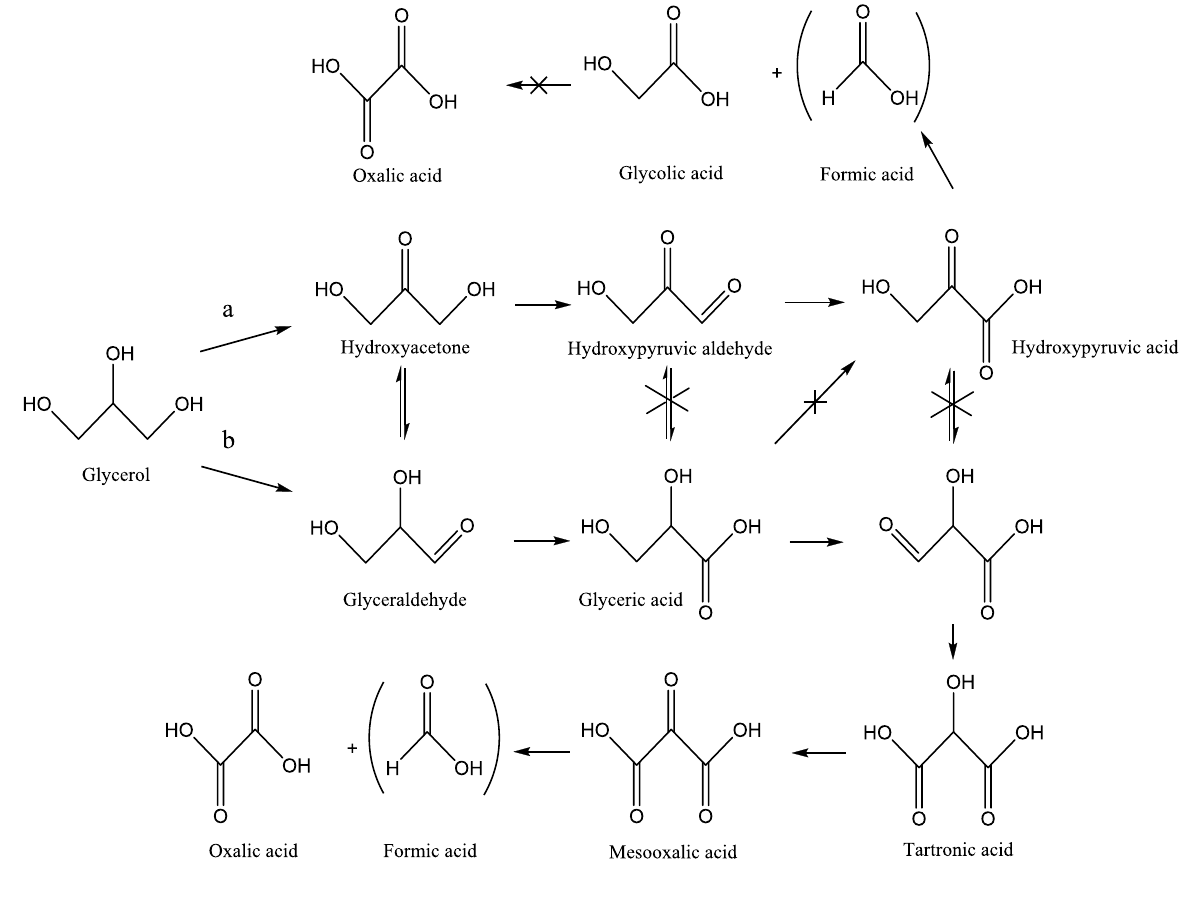
Scheme 2. Reaction scheme for serinol